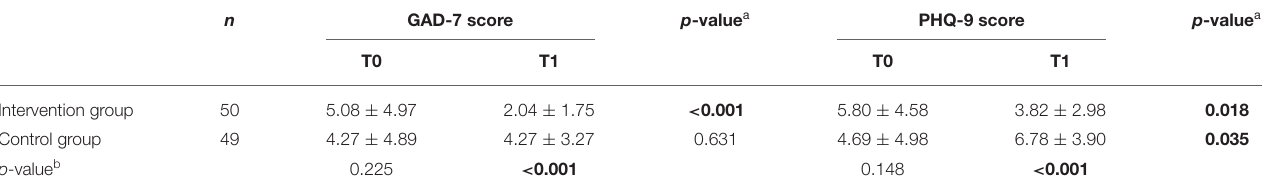
TABLE 2 | GAD-7 and PHQ-9 scores of intervention group and control group at baseline (T0) and 6-month follow-up (T1).